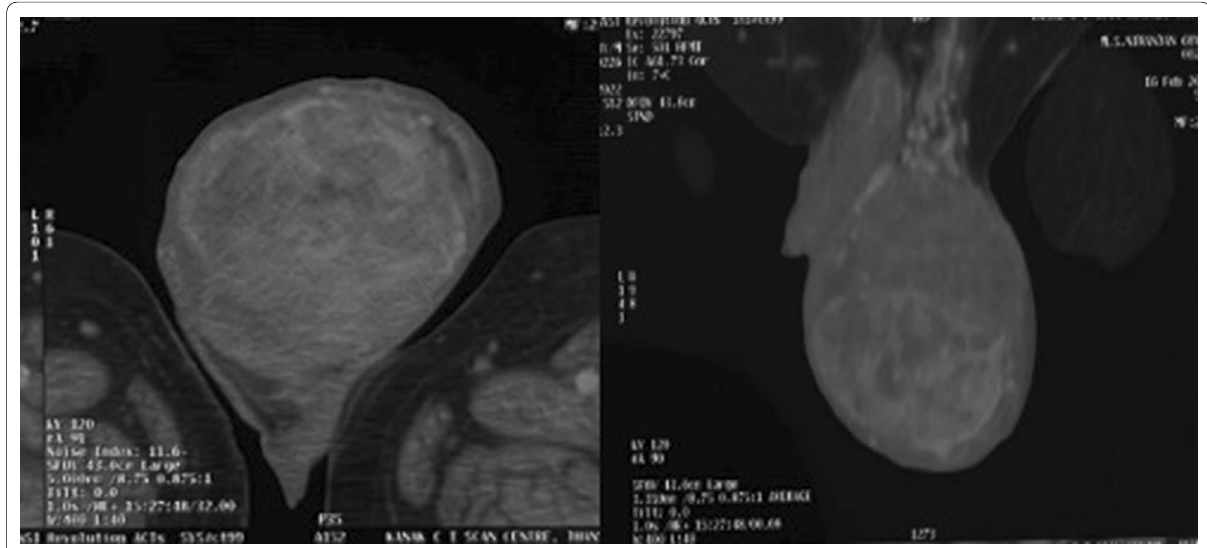
Fig. 1 CECT reveals a heterogenous left testicular mass without any scrotal wall